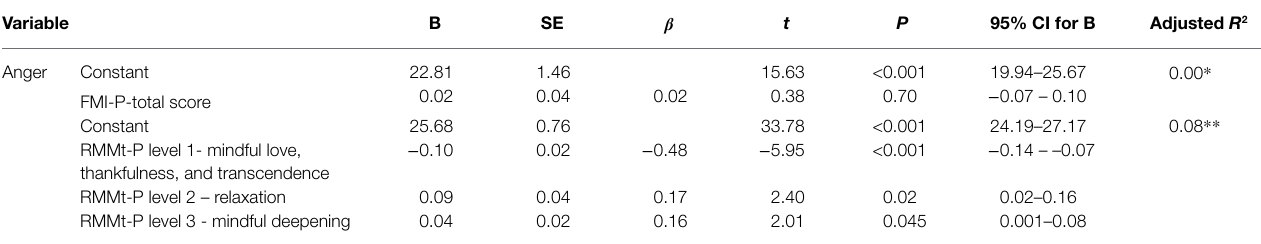
TABLE 5 | Comparison of the linear regression models of RMMt-P and FMI-P for predicting anger.